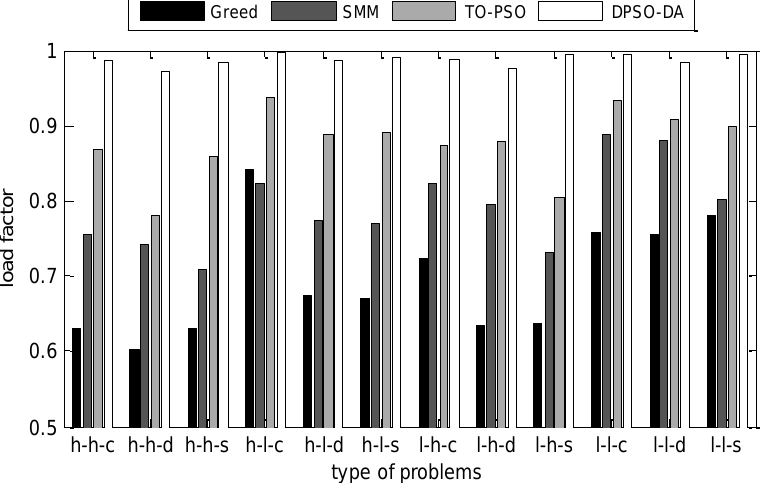
Figure 8. The network load factors under different task allocation solutions.